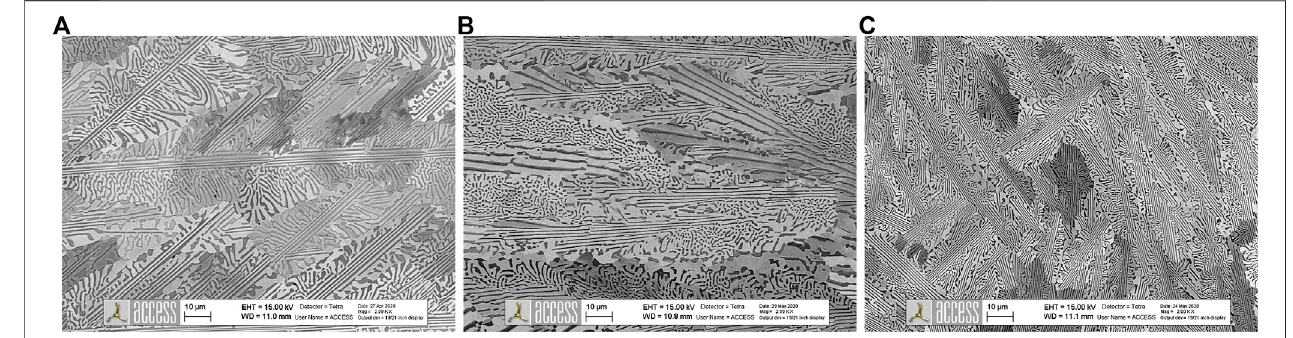
FIGURE 1 | Scanning electron microscopy backscatter-electron micrographs in 2000 X magni fi cation of polished cross sections of as-cast arc-melted cylindrical samples of the Ni 48 Fe 34 Al 18 (A) , Ni 44 Fe 20 Cr 20 Al 16 (B) , and Ni 34.4 Fe 16.4 Co 16.4 Cr 16.4 Al 16.4 alloys (C)